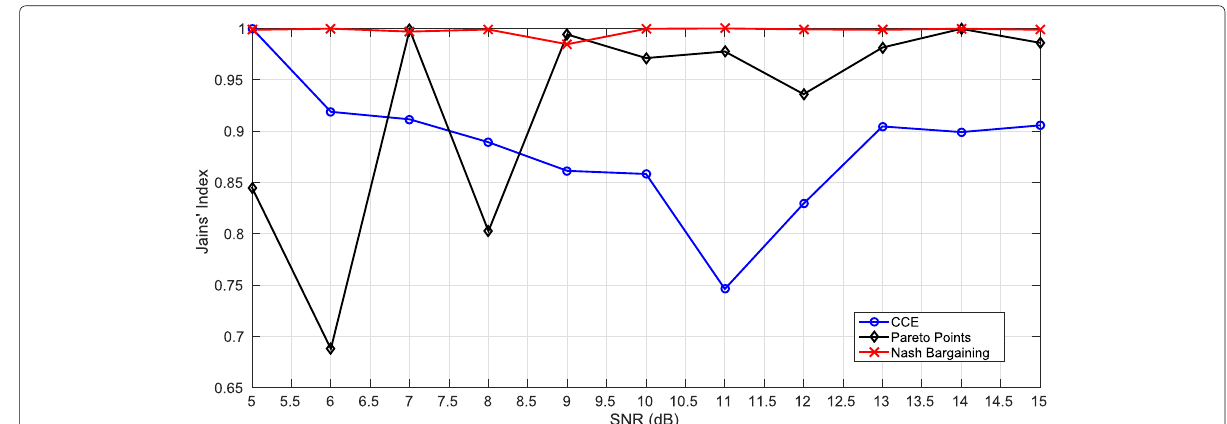
Fig. 11 F-MAC-WT: fairness comparison of CCE, PP and NBS for multiple rate case (with CSI of